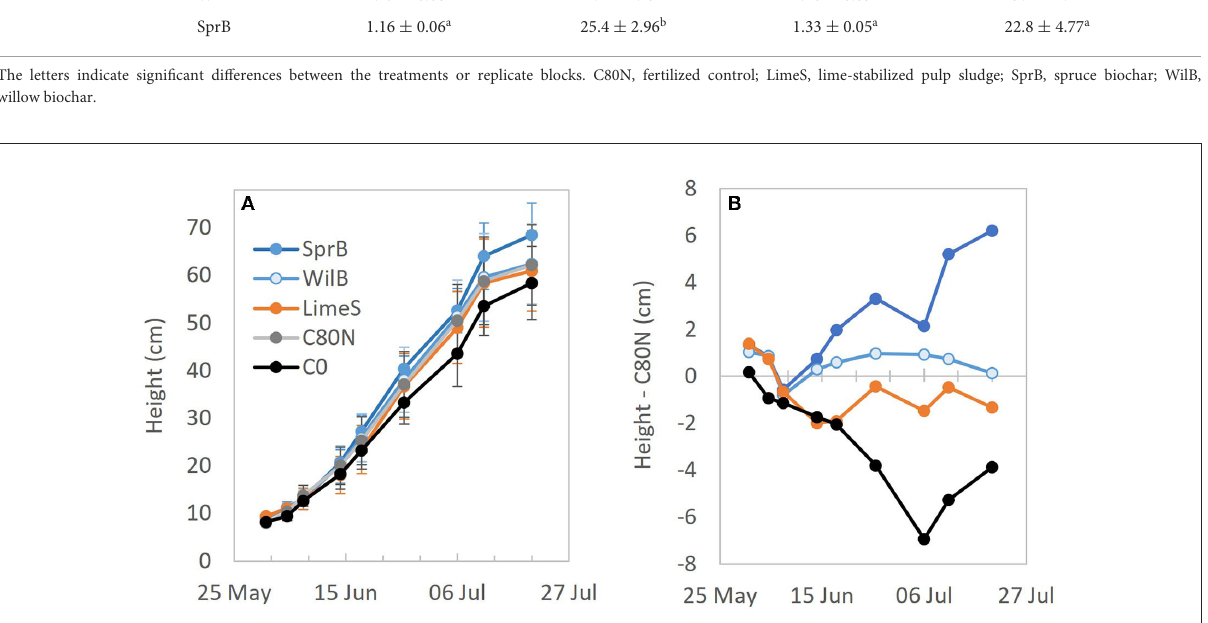
sludge; SprB, spruce biochar; WilB, willow